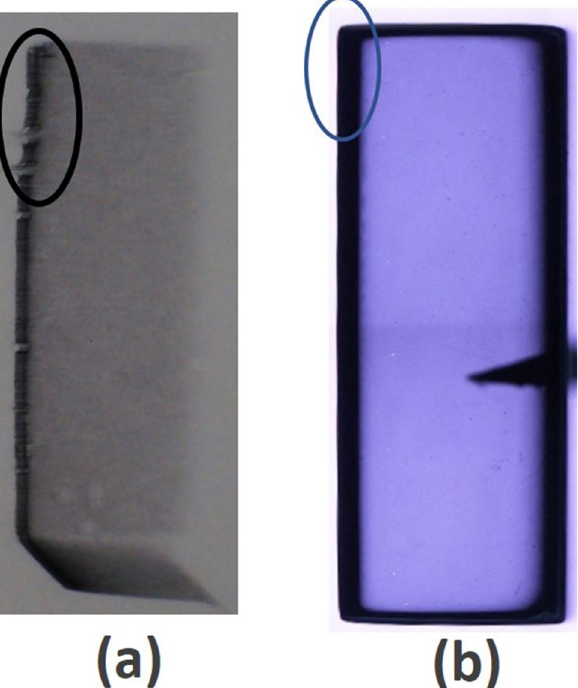
Figure 3. ( a ) X-ray topographic image and ( b ) IR transmission image of the as-grown Cd 0.9 Zn 0.1 Te 0.98 Se 0.02 detector sample. Slight bending on the top left side of the sample is highlighted by the